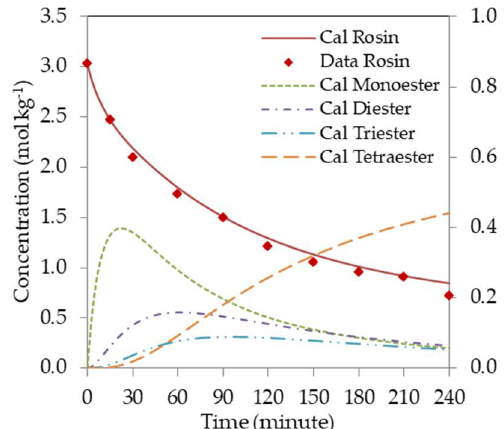
Figure 4. The evolution of calculation results obtained from the proposed kinetics model at 270 °C, with the ratio of 0.8.